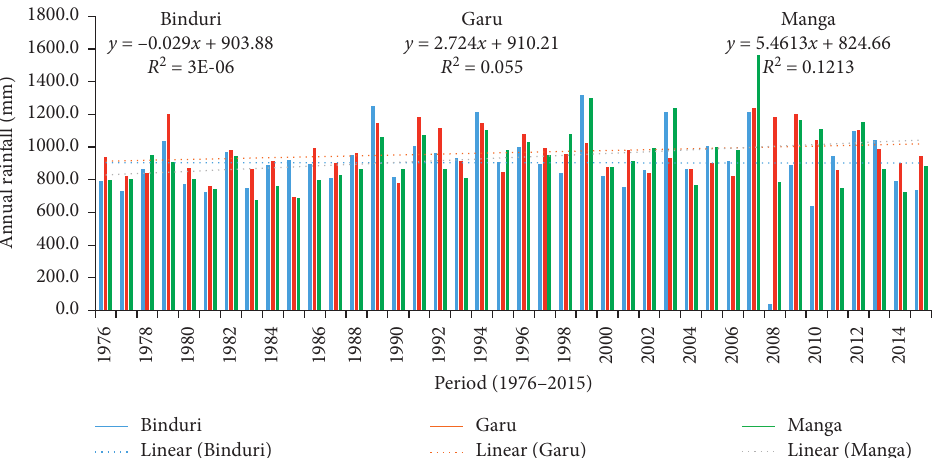
Figure 5: Long-term variability in annual total